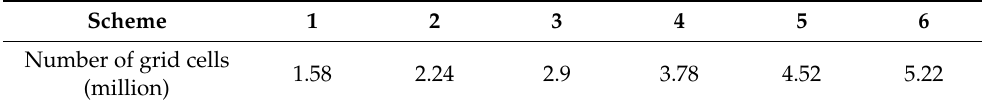
Table 2. Scheme of the grid-independence